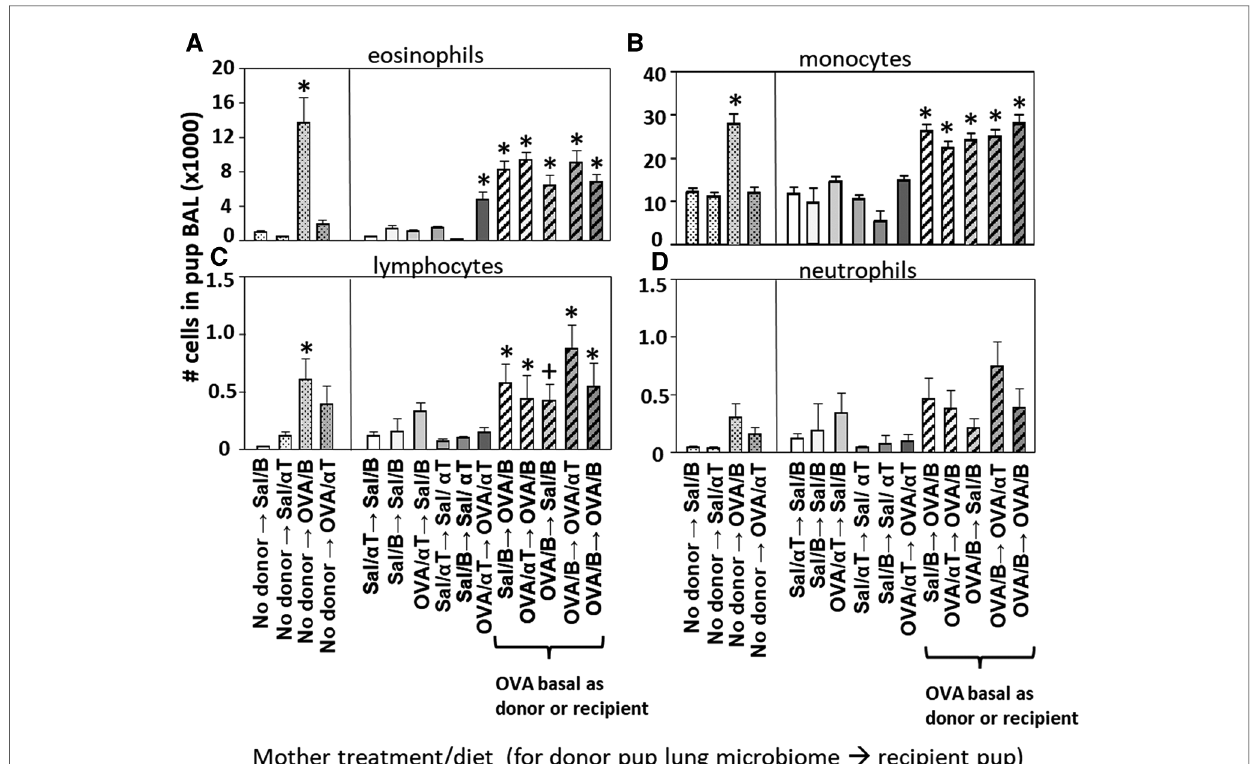
FIGURE 5 Recipient or donor microbiota from pups of allergic mothers (OVA,basal) conferred responsiveness to allergen in the recipient pups (red box). Mice were treated as in timeline in ( Figure 4A ) BAL ( A ) eosinophils, ( B ) monocytes, ( C ) lymphocytes, and ( D ) neutrophils are presented as mean±SEM. Data are from 7 experiments. N =10 – 36/group. Sal/B, saline-treated mother with basal diet. Sal/ α T, saline-treated mother with α T-supplemented diet. OVA/B, OVA allergen-treated mother with a basal diet. OVA/ α T, OVA allergen-treated mother with α T-supplemented diet. * p <0.05 as compared to the saline, basal → saline,basal group., + p <0.1 as compared to no donor → Saline/basal